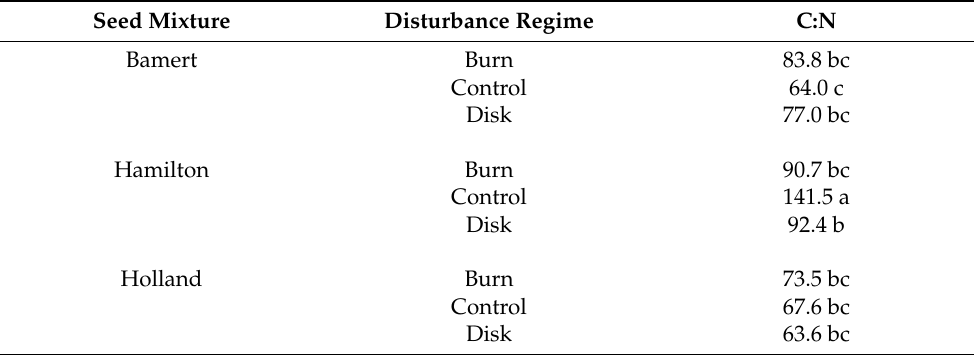
Table 3. Biomass C:N ratio by pollinator mixture and disturbance regime measured at the Natural Resources Conservation Service Plant Materials Center in Booneville, AR, in 2016 and